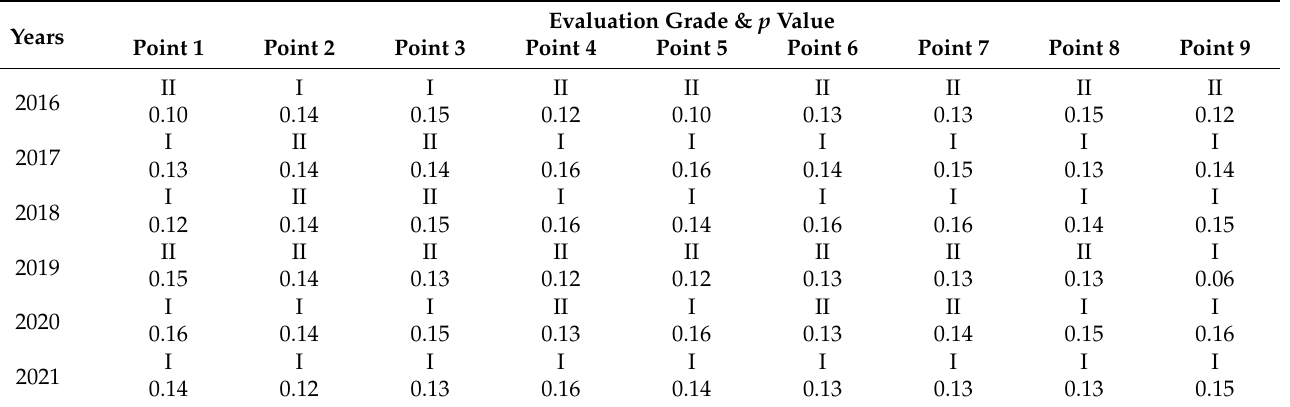
Table 6. Water quality assessment results of typical wetlands in the source region of the Yangtze River by Bayesian method from 2016 to 2021.